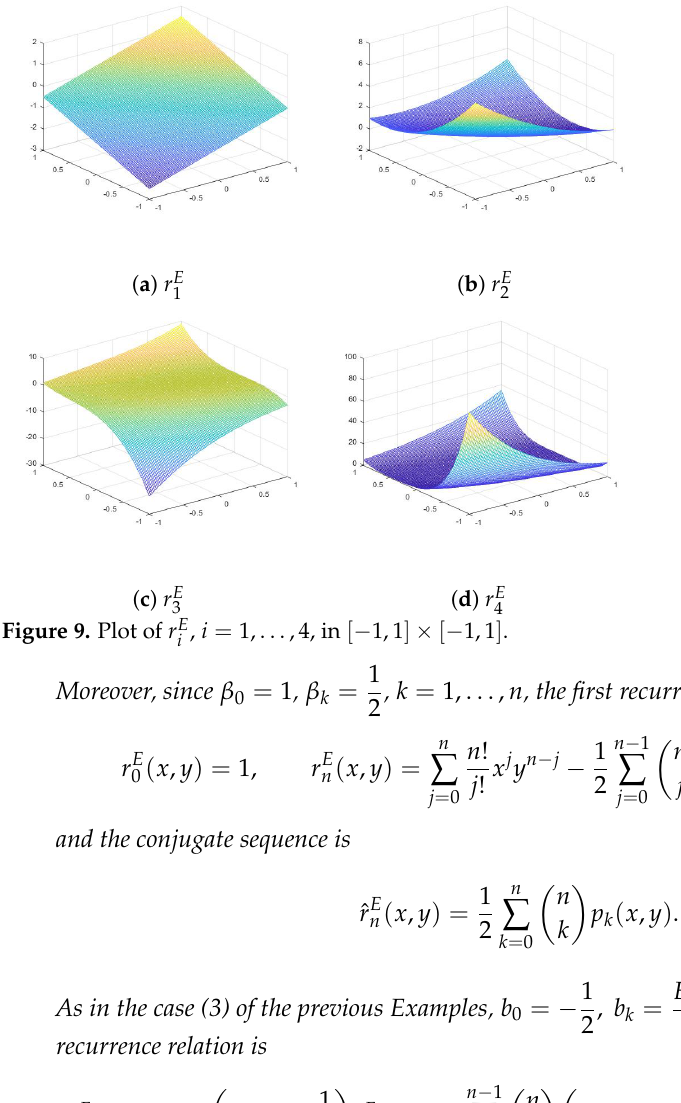
, i = 1, . . . ,4, in [ − 1,1 ] × [ − 1,1 ] i